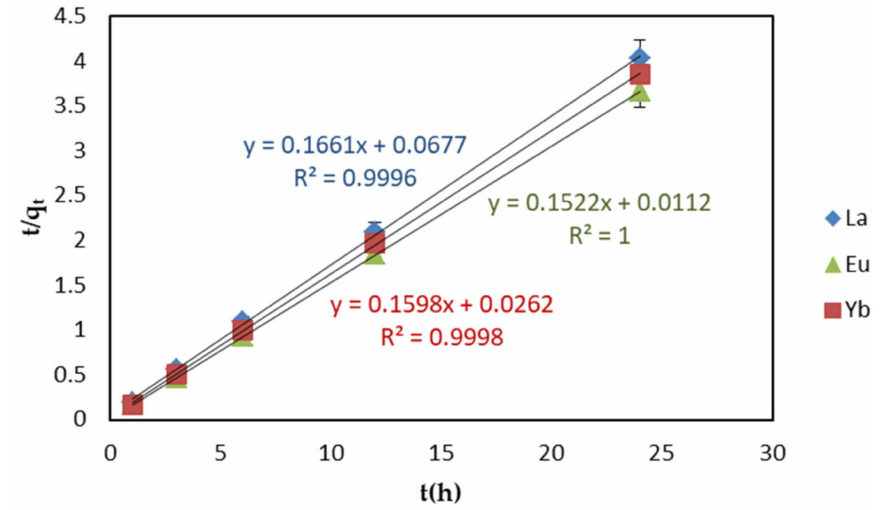
Figure 10. Pseudo − second − order linear kinetic models of REEs adsorption on EDTA–CS@ZIF-8. Table 2. Parameters for two kinetic models of adsorption of REEs by EDTA–CS@ZIF-8.